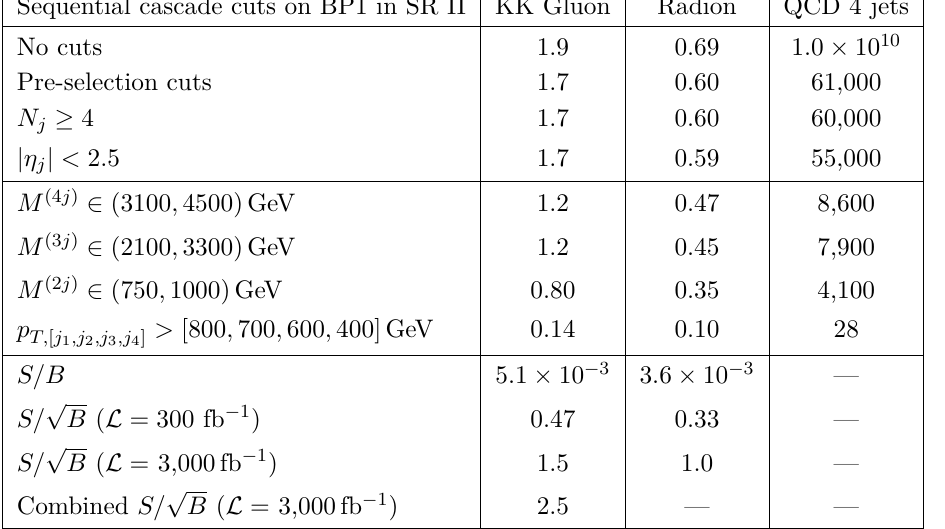
— — = 3 . 5 , (cid:15) = 1 , m ( G ) = 4 TeV , m ( g ) = KK KK KK > T, [ j 1 ,j 2 ,j 3 ,j 4 ]